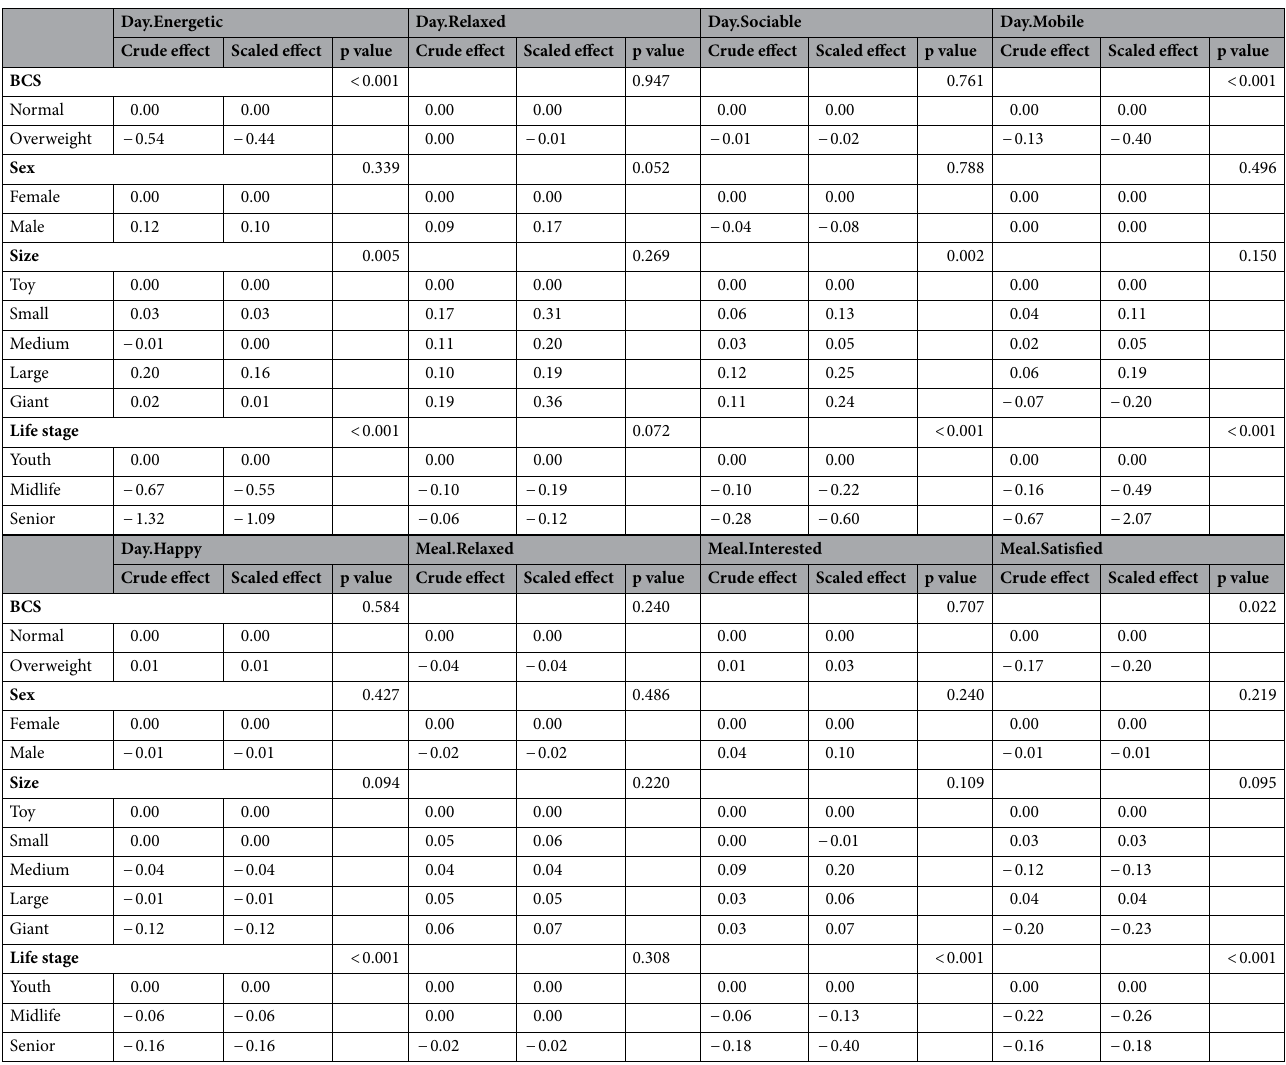
Table 2. Effect of body condition score (BCS), sex, size and life stage on domain score. Effects are expressed versus a reference category either on the 1 to 7 domain score scale (crude effect) or approximately scaled to the domain score population standard deviation (scaled